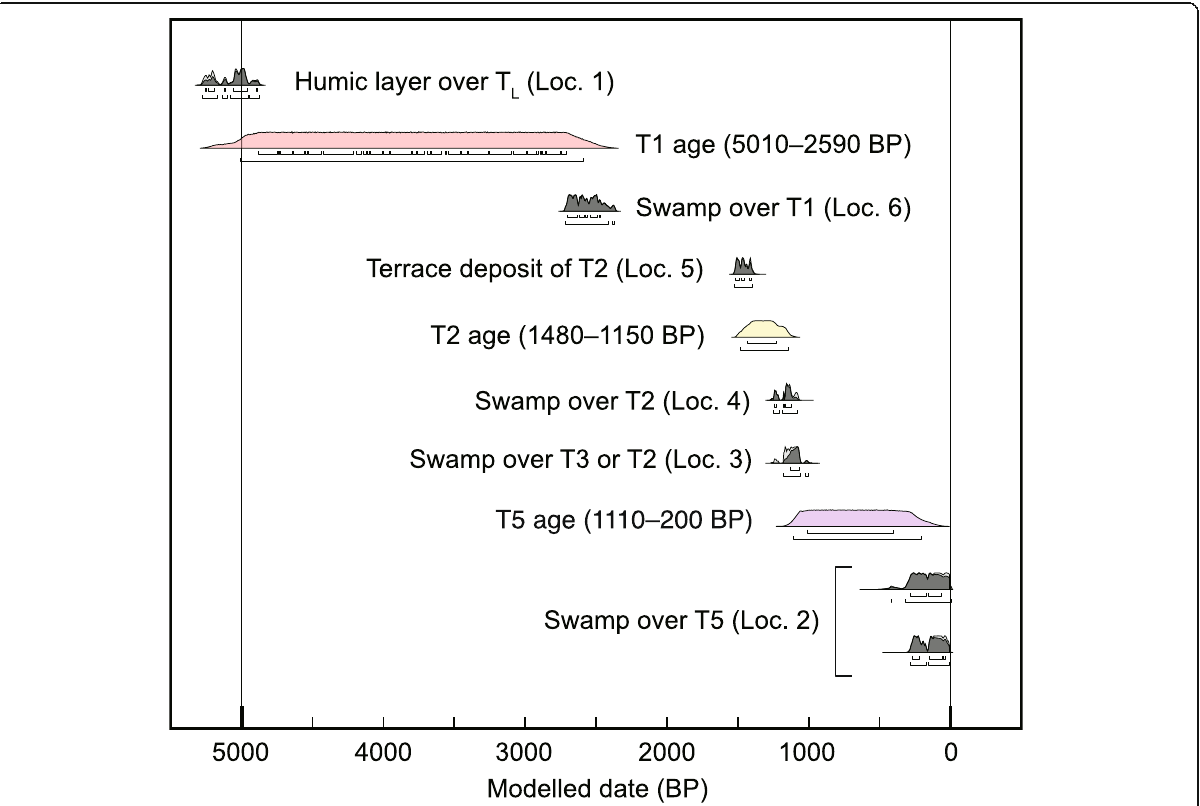
Fig. 7 Modeled ages of the terraces and their probability density functions. Original Oxcal output is shown in Fig. S3